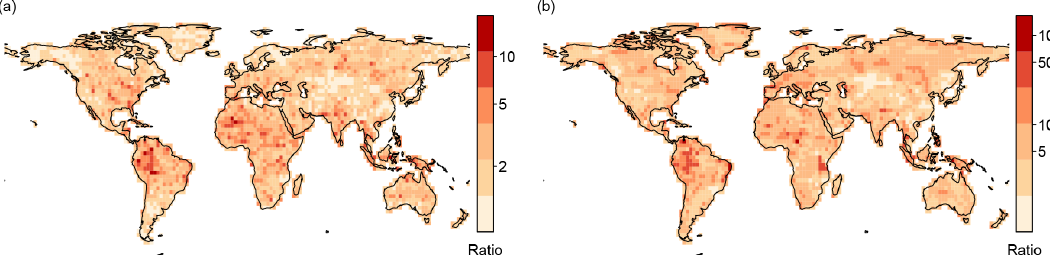
Figure 8. (a) Ratio between full range and noise (uncertainty associated with internal variability) at the 90th percentile of heat stress (WBGT) based on a perfect model approach using UQM to adjust biases; (b) ratio between the range of all models and the range of all five CanESM runs of correlation between temperature and relative humidity.